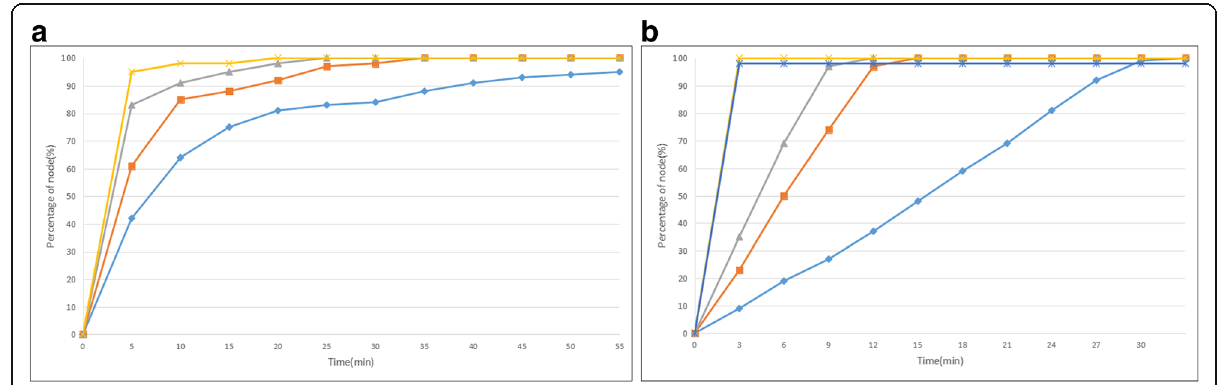
Fig. 8 Efficiency of synchronization for a densely deployed network. a The random path case. b The designed path